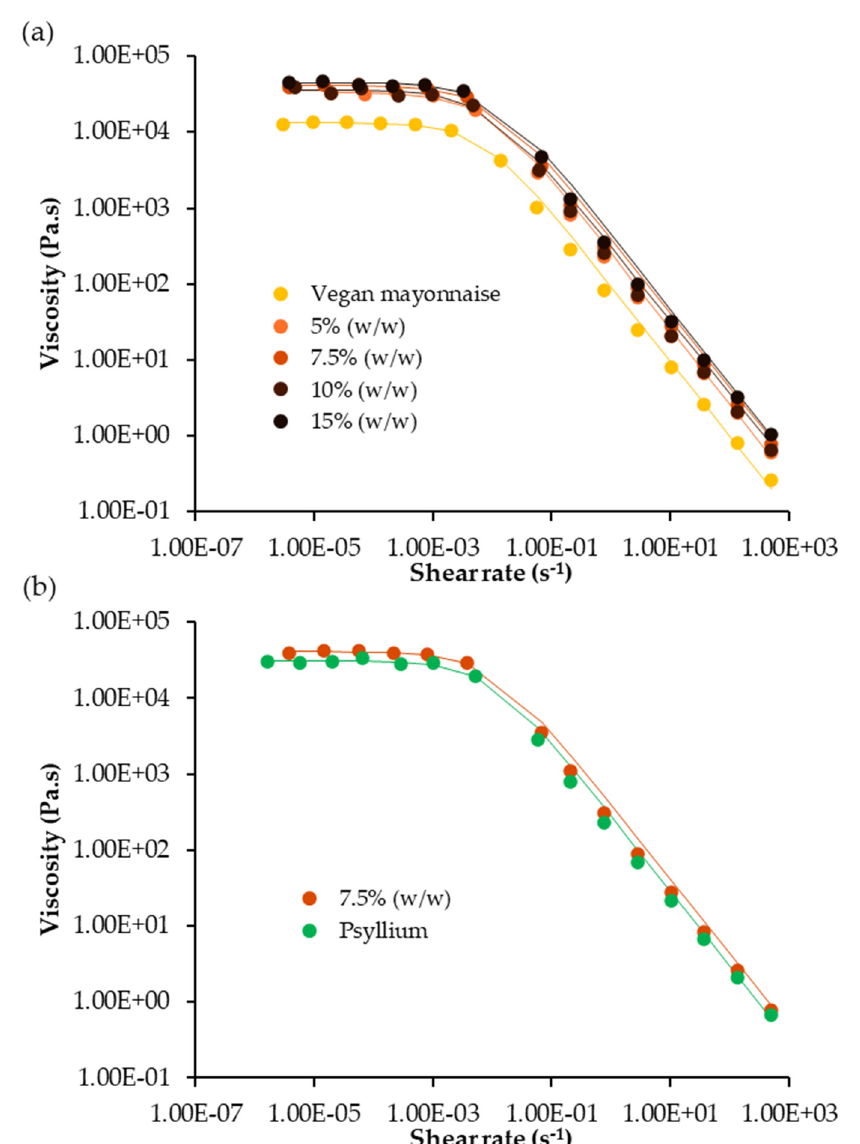
Figure 7. Flow curves of emulsions ( a ) standard and with 5, 7.5, 10 and 15% ( w / w ) of miso paste; ( b ) with 7.5% ( w / w ) of miso paste, one of them with 0.1% ( w / w ) of psyllium husk. Lines represent Williamson’s model adjustment.